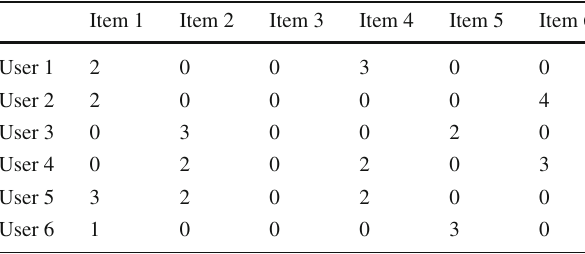
Table 1 Example of a user-item rating